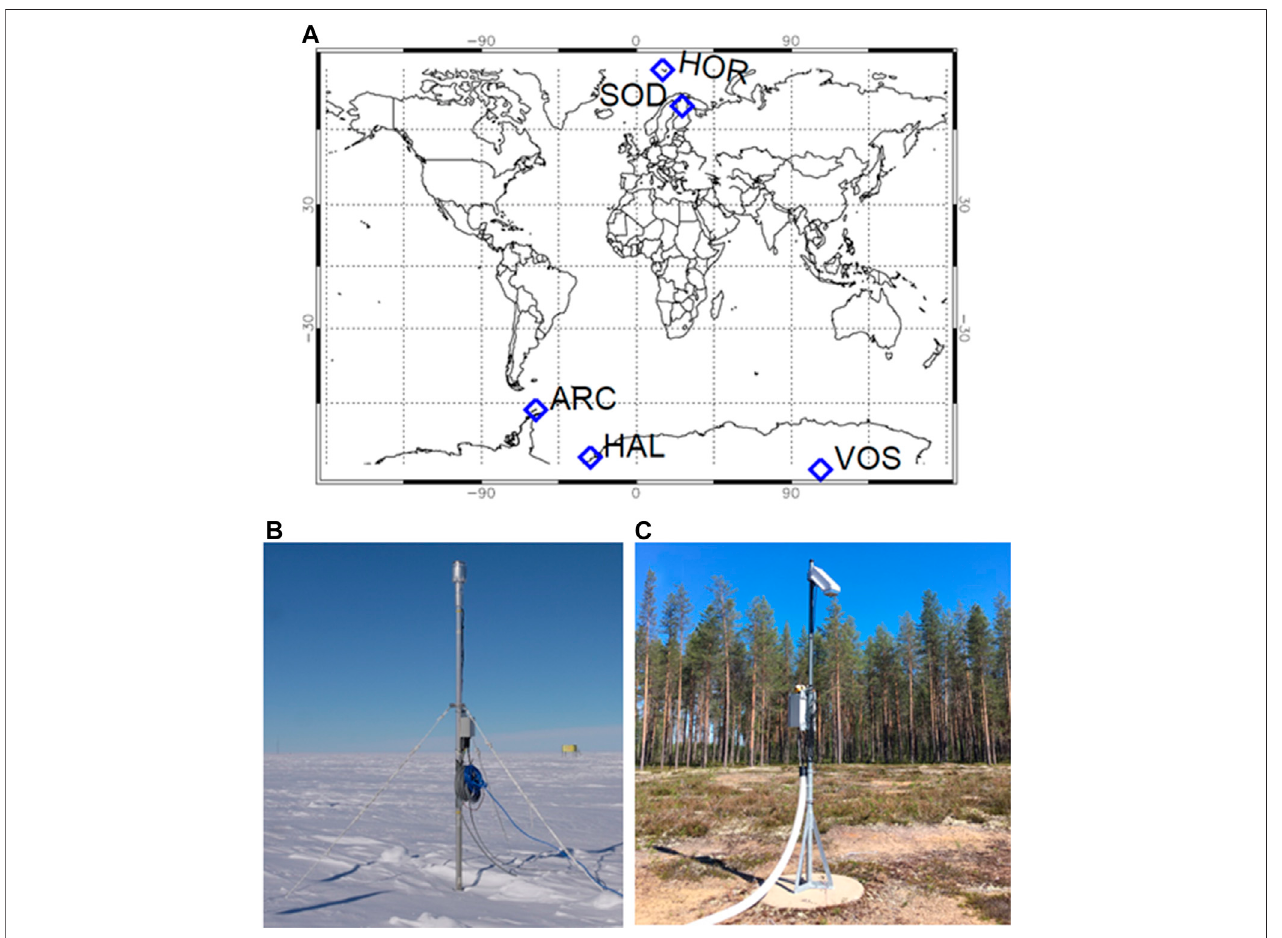
FIGURE 1 | (A) Map showing location of high latitude measurement sites described in the paper (denoted by blue diamonds). HOR, Hornsund, SOD, Sodankyla Geophysical Observatory, ARC, Arctowski, HAL, Halley, VOS, Vostok. Photo showing electric fi eld mill at (B) Halley, and (C) Sodankyla.